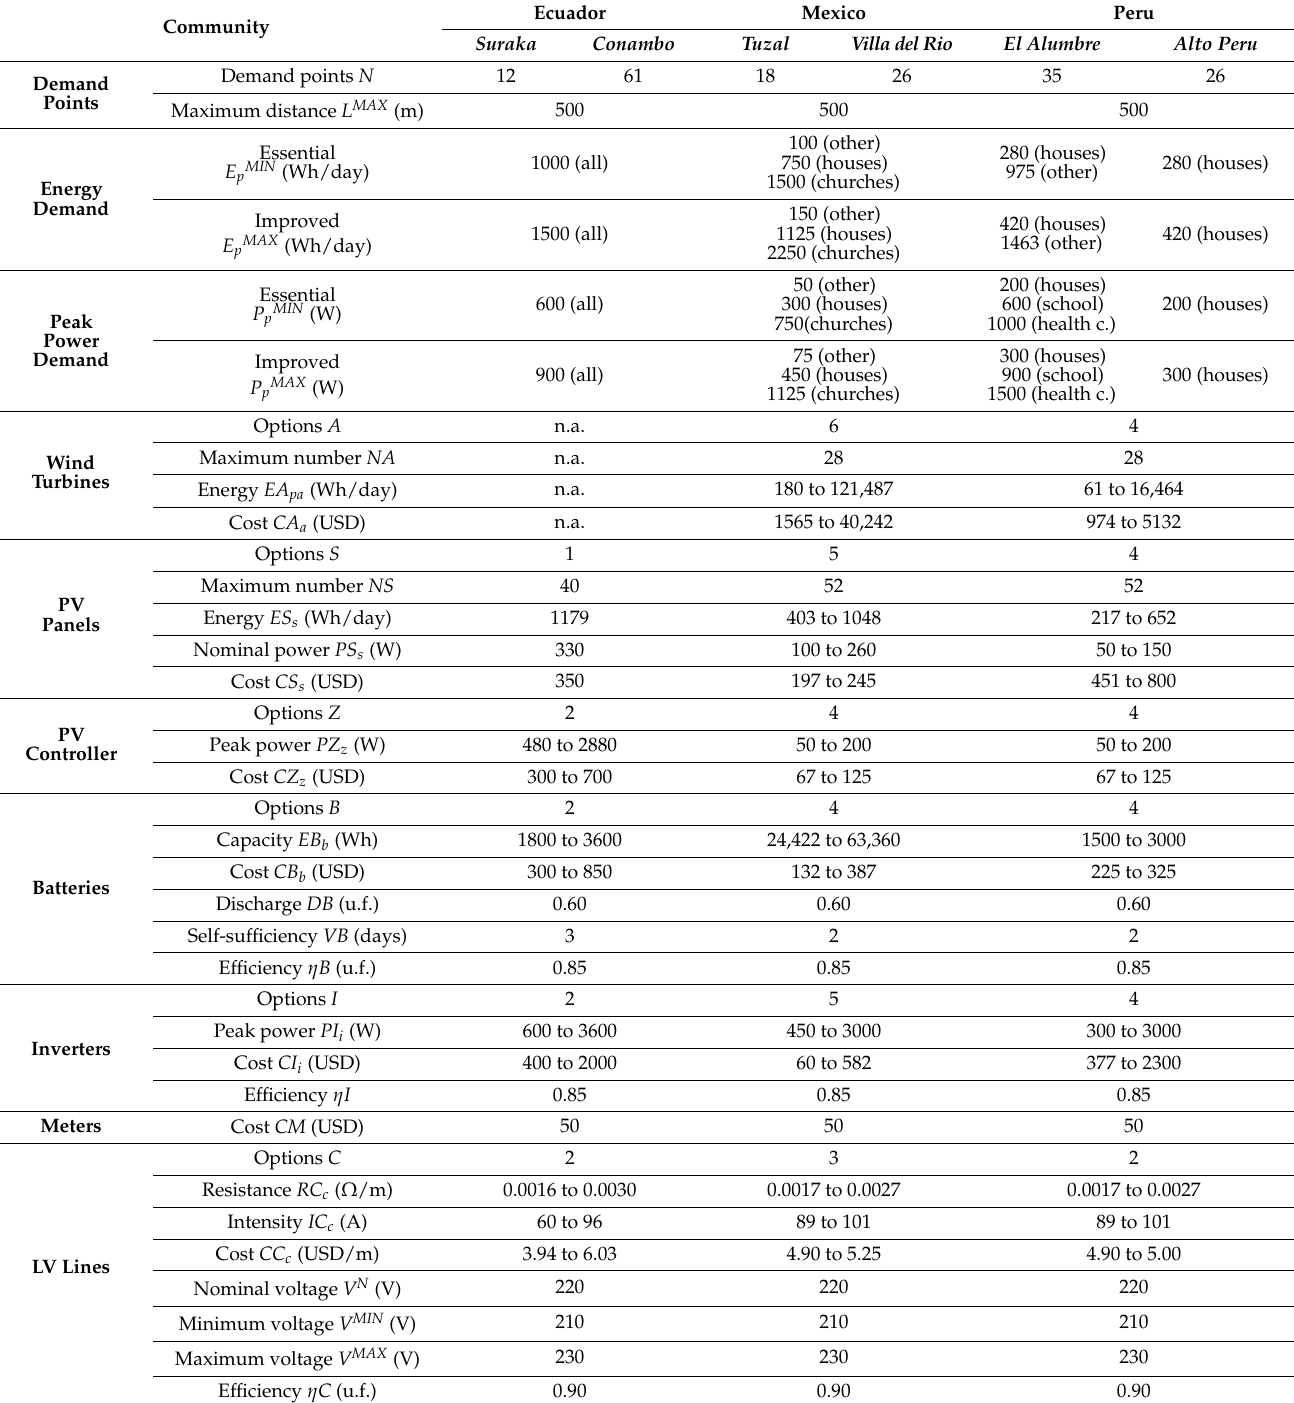
Table 1. Input data for each community and